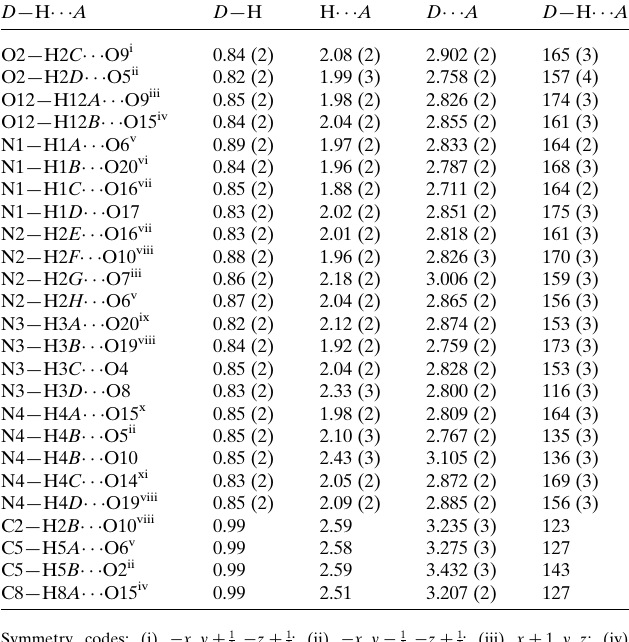
Table 1 Hydrogen-bond geometry (A˚ , (cid:5) ).